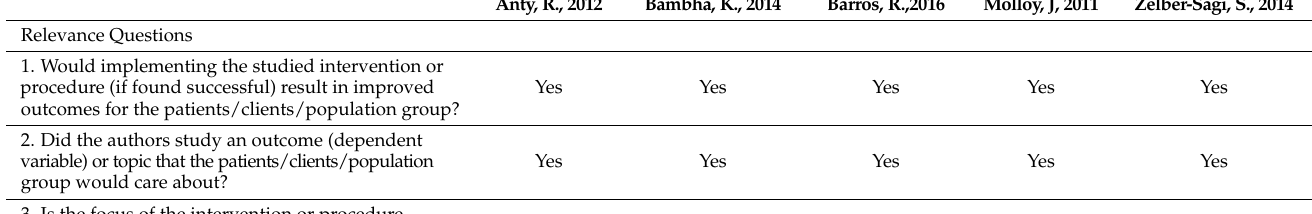
Table A1. Quality assessment